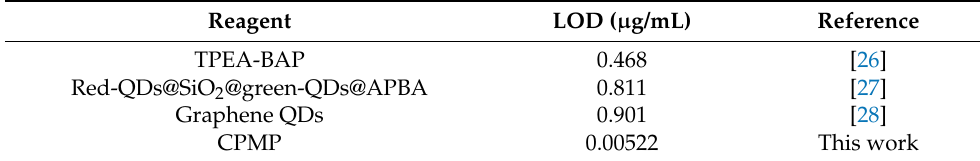
Table 7. Comparison of CPMP with other glucose probes